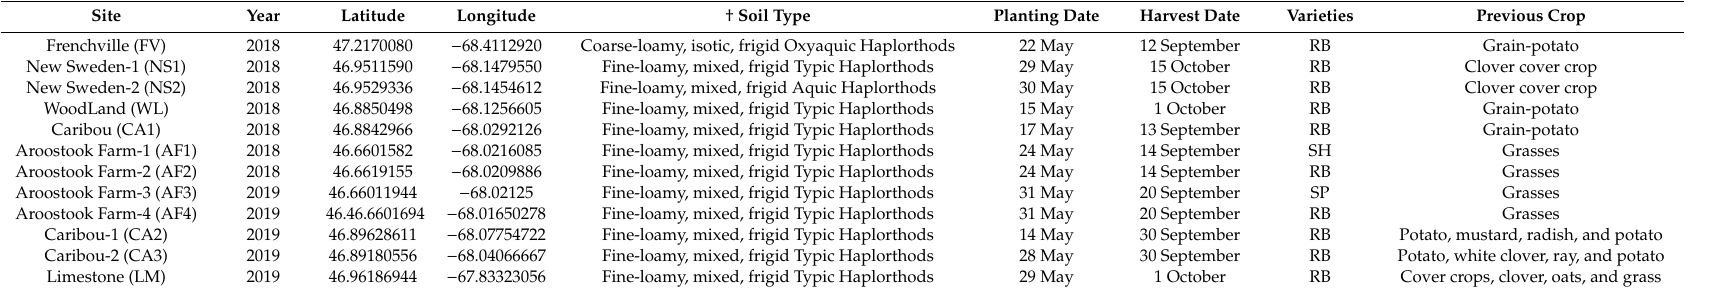
Table 1. Field experiment information in 2018 and